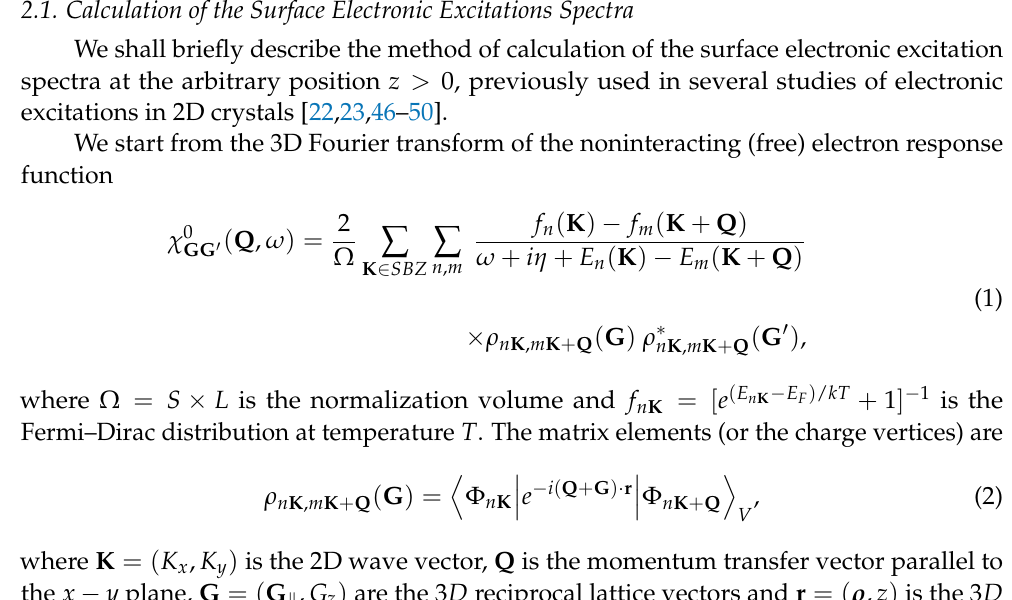
Figure 1. Schematic representation of the AC 8 crystal deposited on a dielectric substrate described by a local dielectric function (cid:101) S ( ω ) . The substrate (blue) occupies the region z < − h , the graphene layer (yellow) is in the z = 0 plane and the alkali atom (turquoise) layer is in the z = − d